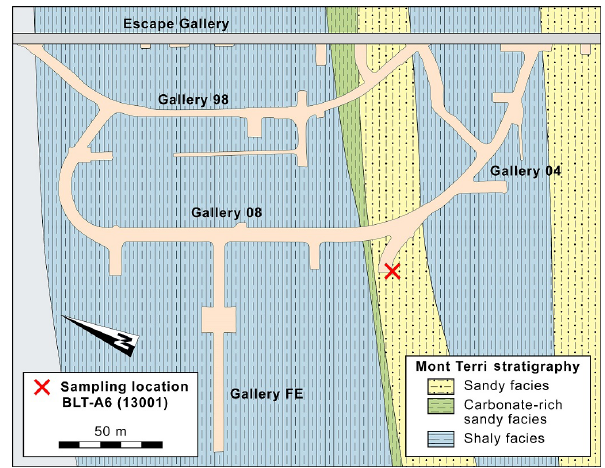
Figure 3. Schematic overview of the Mont Terri underground rock laboratory, showing the sampling location of the Opalinus Clay used for this